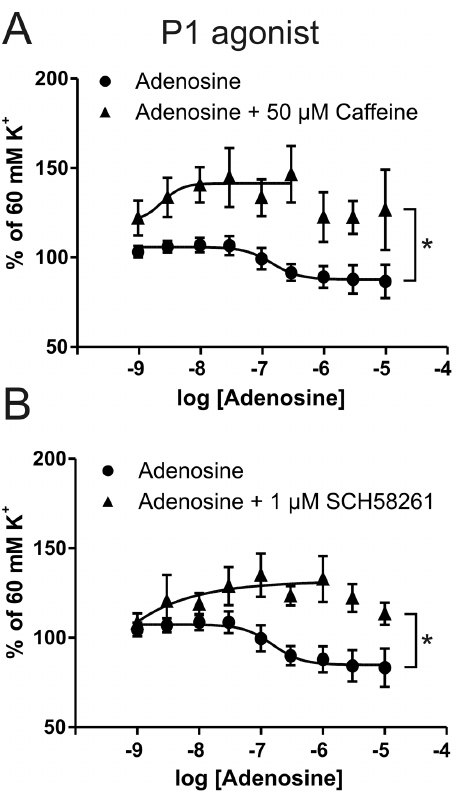
Figure 5. Effects of adenosine and caffeine on MMA. A) Adenosine causes a relaxation of the MMA, and 50 m M caffeine inhibits the relaxation and causes a contraction *=p curve =0.029, with two way ANOVA. B) 1 m M SCH58261, a specific A2A antagonist mimics the antagonism of caffeine *=p curve =0.015, with two way ANOVA (n=5).